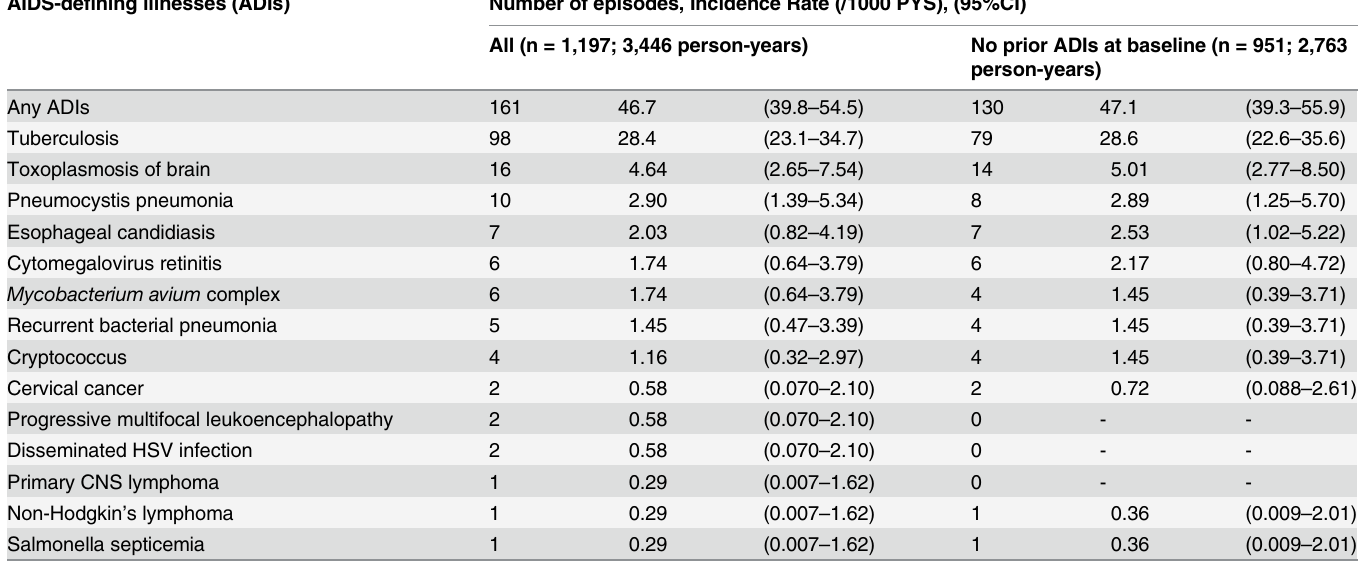
Table 2. Incidence Rates of AIDS-Defining Opportunistic Infections during ART.